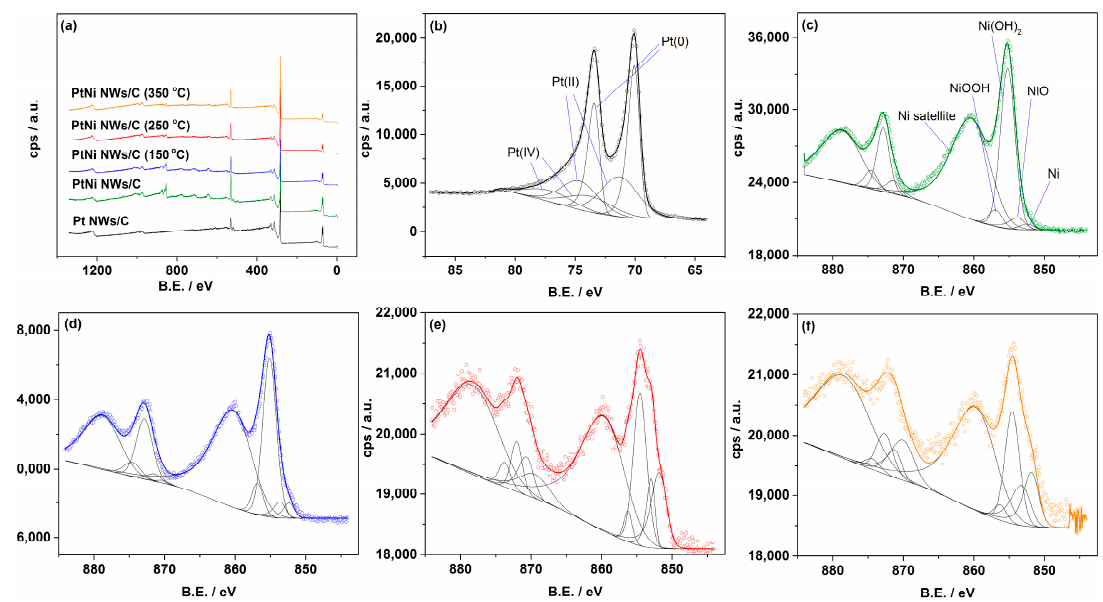
Figure 3. ( a ) XPS Survey scan of Pt NWs/C, PtNi NWs/C, and PtNi NWs/C annealed at various temperatures. XPS patterns of ( b ) Pt 4f scan for Pt NWs/C; ( c ) Ni 3p scan for PtNi NWs/C; ( d ) Ni 3p scan for PtNi NWs/C (150 °C); ( e ) Ni 3p scan for PtNi NWs/C (250 °C); and ( f ) Ni 3p scan for PtNi NWs/C (350 °C).